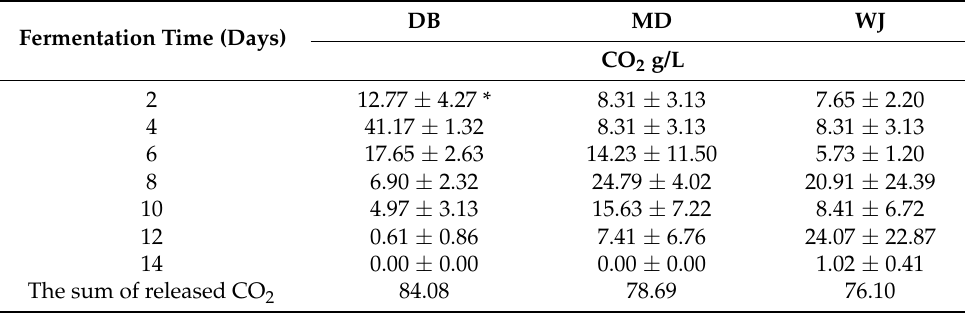
Table 3. Kinetics of CO 2 releasing in DB, MD, and WJ musts.